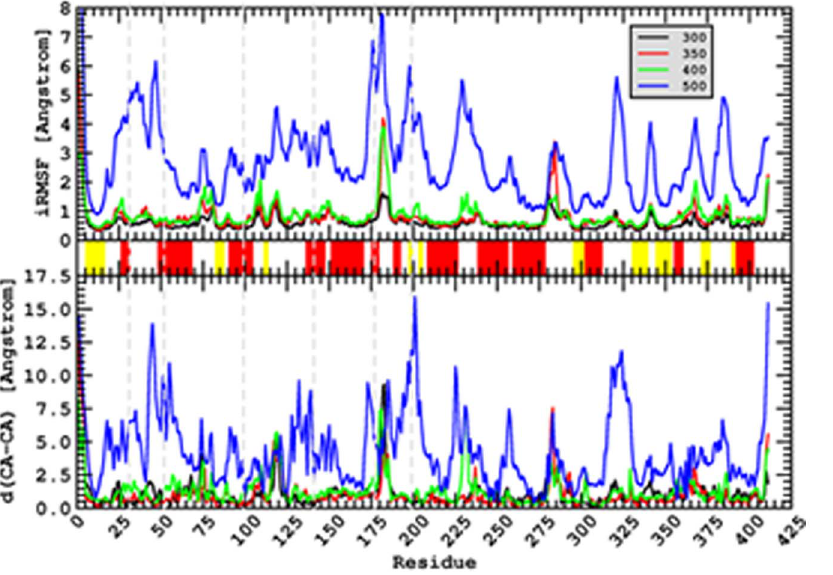
Figure 1. Molecular Dynamics simulations performed on a homology model of the phytase from C.braakii . Simulations were performed at several temperatures (shown in Kelvin in the inset of the upper panel). Upper panel: isotropic root mean square deviations (iRMSF) of the C a at the different temperatures. Middle panel: secondary structure assignment with red regions representing a -helices and yellow regions representing b - sheets. Bottom panel: mean distances between C a of the starting structure and C a of the structures at different temperatures. These profiles suggest that at high temperature the enzyme displays an unfolding behavior while at low temperatures the available thermal energy is only able to excite fluctuations of specific regions. Dashed grey lines mark the position of the residues mutated to engineer disulfide bridges.